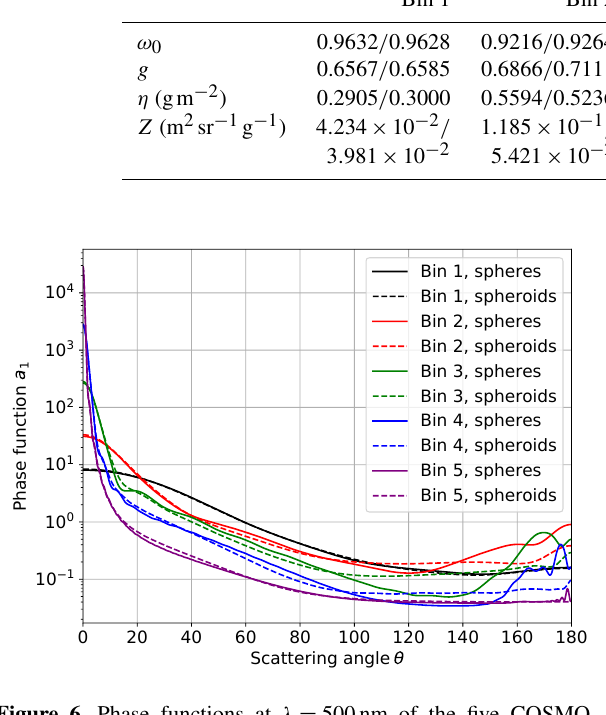
Figure 6. Phase functions at λ = 500nm of the five COSMO- MUSCAT dust size bins (different colors) assuming spherical par- ticles (solid lines) and prolate spheroids (dashed lines). For details, see text.